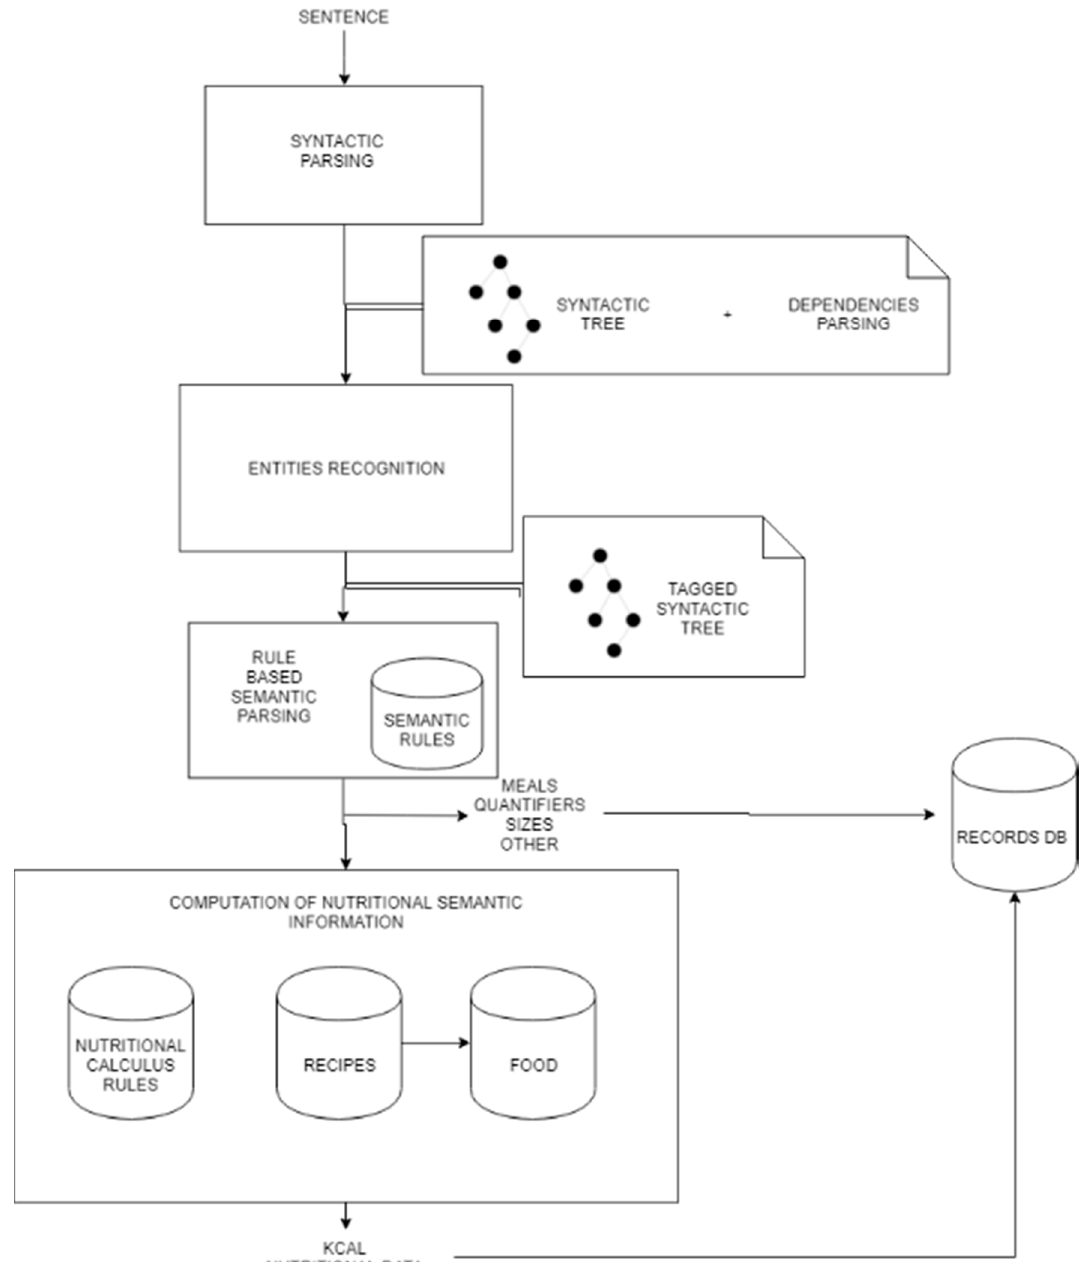
Figure 2. Schema of the proposed